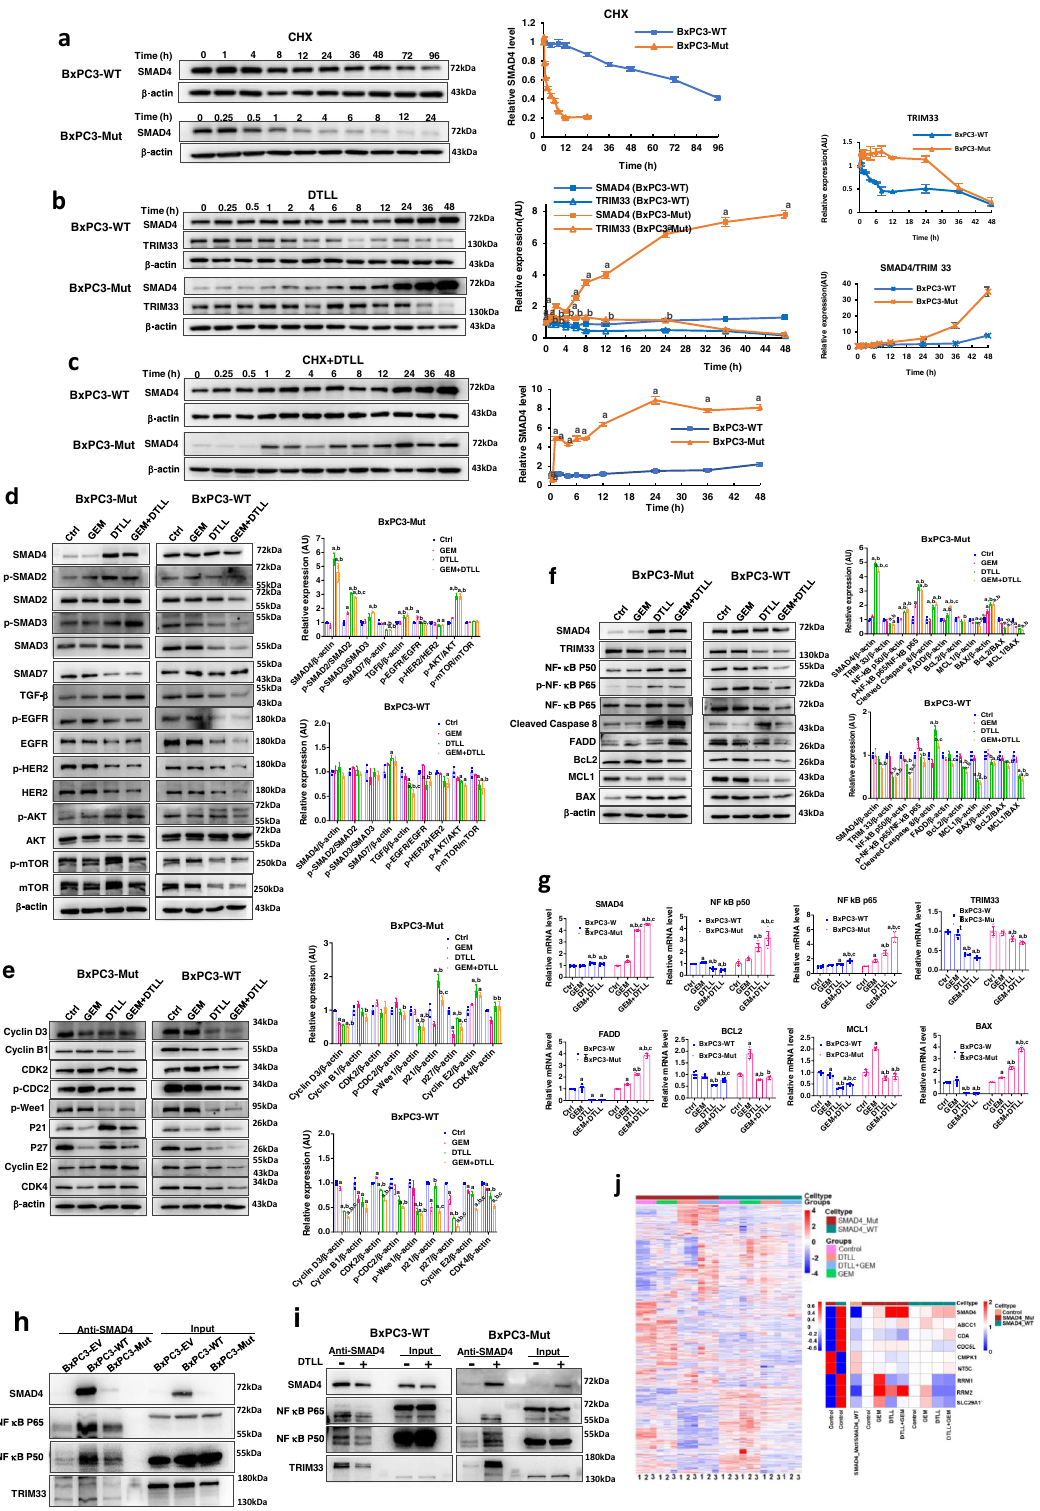
antiapoptotic proteins (Bcl-2 and MCL1) of the BxPC3-WT line (Fig. 8d – g) through the regulation of upstream NF- κ B transcriptional activity. Moreover, NF- κ B expression was controlled as a target of either mutant or wild-type SMAD4, and the interaction of those two proteins in BxPC3-Mut and BxPC3-WT cell lines exhibited differentlyin an opposite direction (Fig. 8h, i). The trends in protein expression affected by DTLL (including NF-kB, TRIM33 and apoptosis-relevant